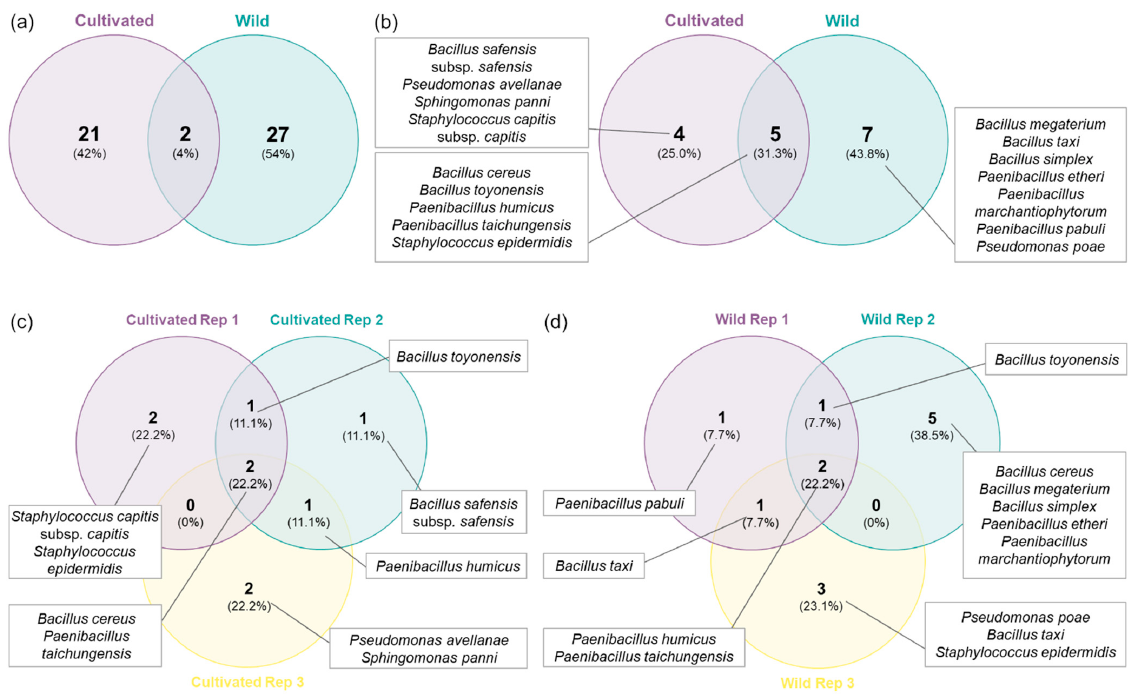
Figure 2. Venn diagrams with the number of RAPD profiles and bacteria species: ( a ) RAPD profiles from orchard and wild plants; ( b ) endophytic bacteria species from orchard and wild plants; ( c ) endophytic bacteria species from cultivated plant replicates; ( d ) endophytic bacteria species from wild plant replicates.